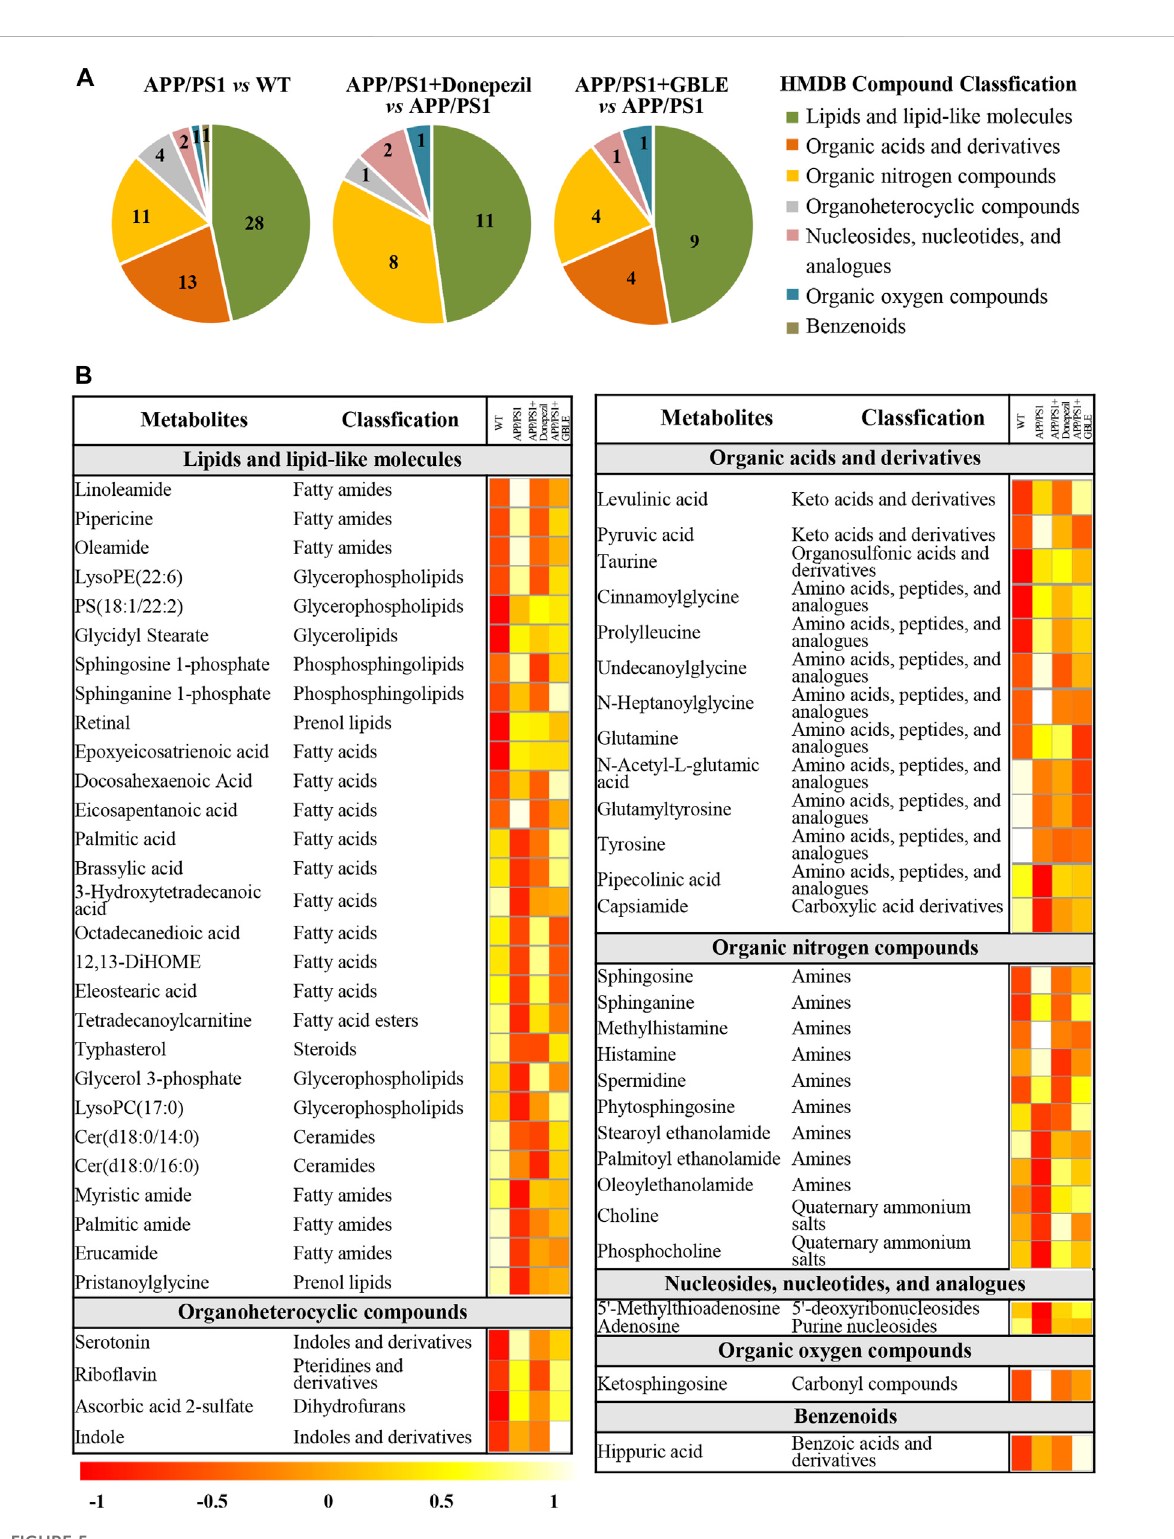
Classi fi cation and heatmap analysis of differential metabolites. (A) Pie charts showing the HMDB compound classi fi cation of disorded metabolites in APP/PS1 and regulated metabolites by Donepezil and GBLE, respectively. (B) Heat map showing the average levels of metabolites in each group. The colors from red to white in the heatmap indicate higher levels of